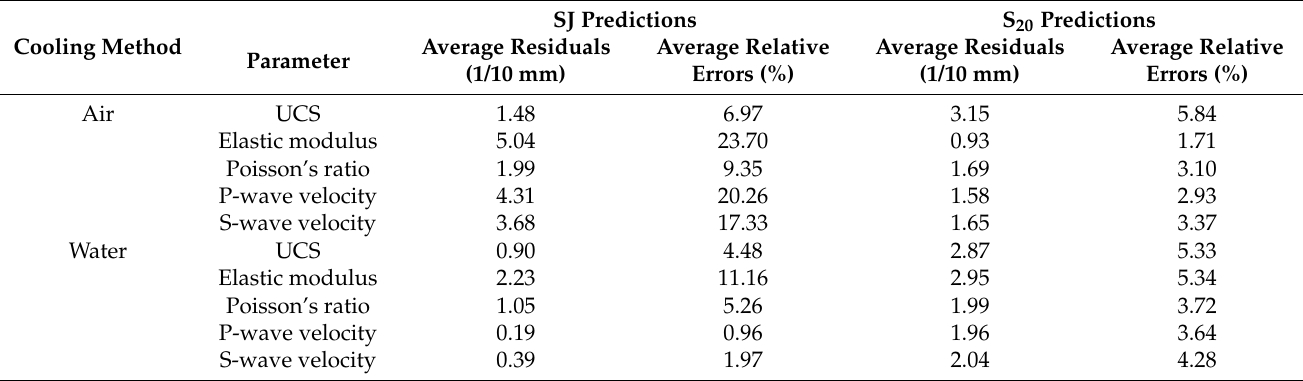
Table 4. Average residuals and relative errors for predictions of SJ and S 20 from physical and mechanical variables at the highest temperatures (400, 500, and 600 ◦ C). SJ Predictions S 20 Cooling Method